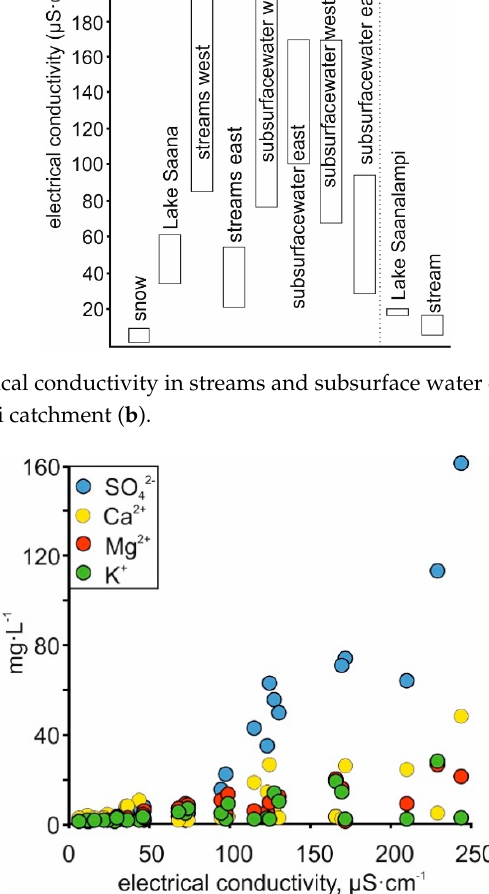
Figure 6. Variations of major ions in dependence on electrical conductivity in stream samples.